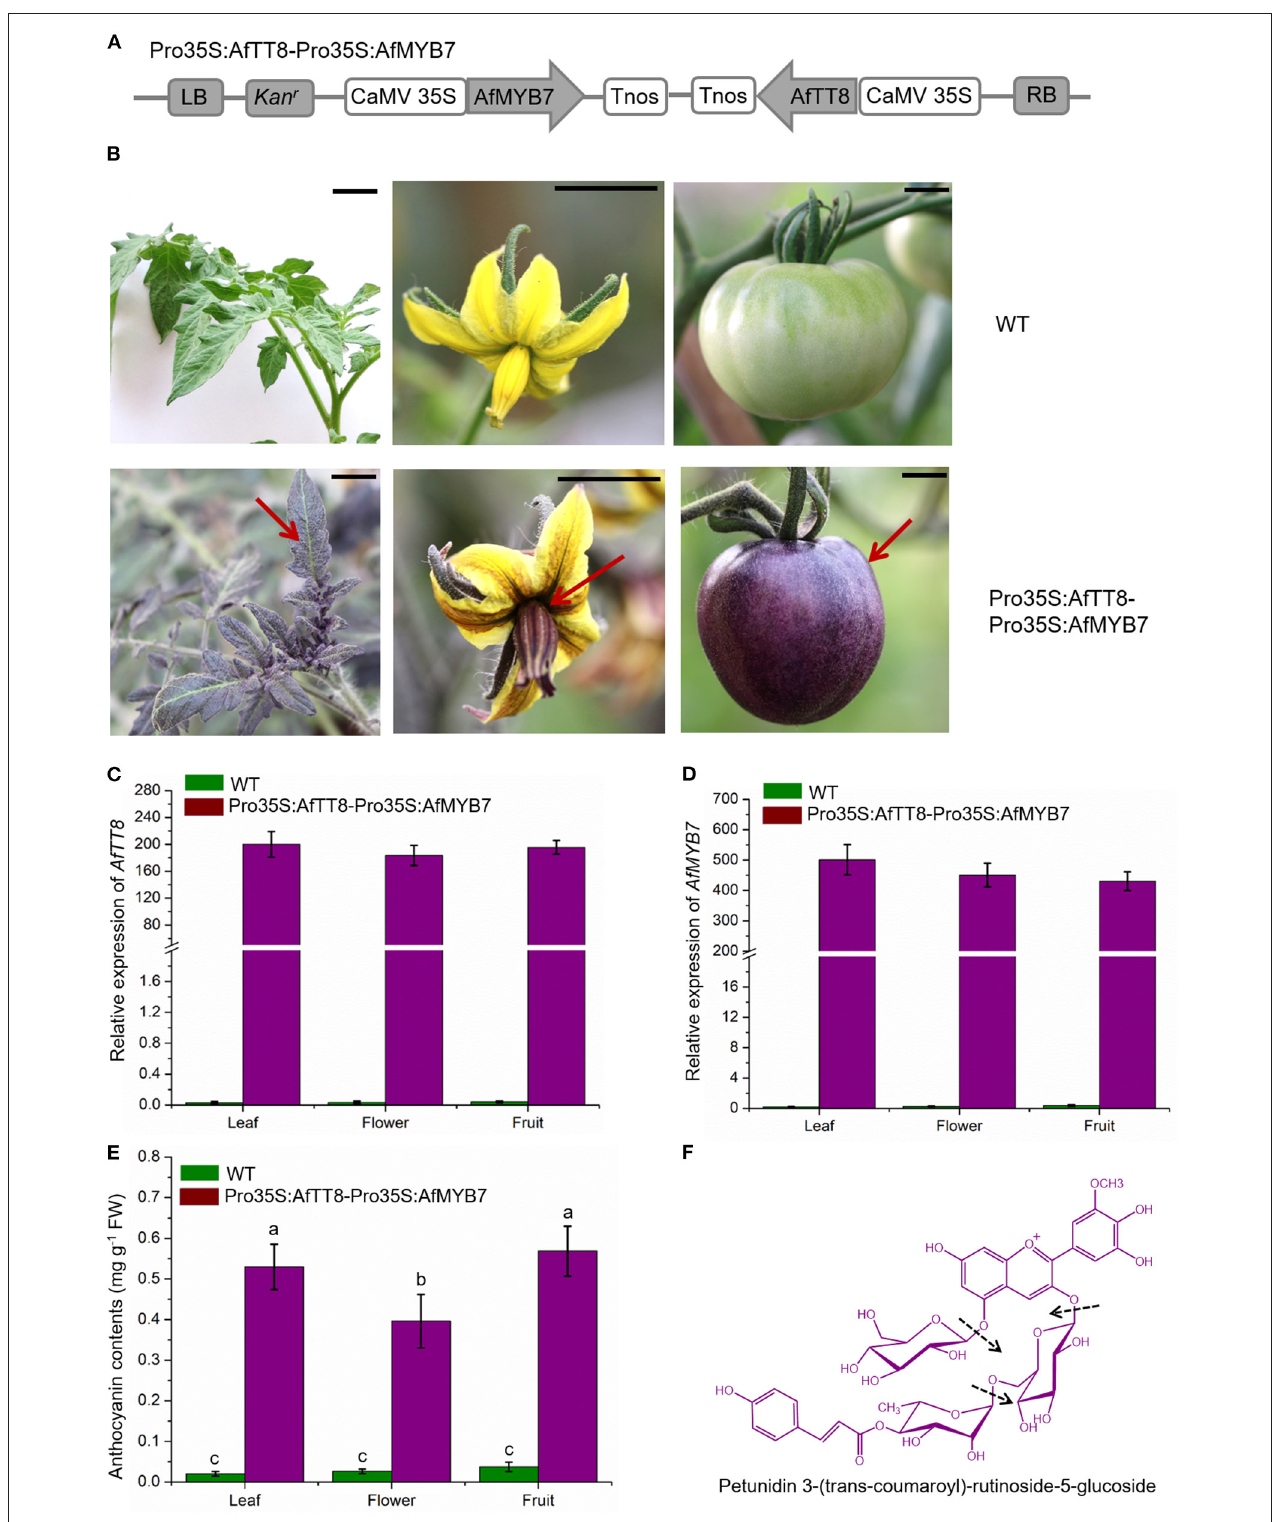
FIGURE 7 | AfMYB7 and AfTT8 coordinately trigger anthocyanin biosynthesis in various tomato tissues. (A) Schematic representation of the co-expression vector Pro35S:AfTT8-Pro35S:AfMYB7. (B) Phenotypes of WT (wild type) and transgenic tomato plants. Expression analysis of AfTT8 (C) and AfMYB7 (D) in WT and transgenic tomato lines. Gene expression levels were normalized to SlCAC . (E) The contents of total anthocyanins in various tissues. (F) Structure of the major anthocyanin petunidin 3-(trans-coumaroyl)-rutinoside-5-glucoside in reference to peak 3 in Supplementary Figure S6A and the cleavage sites were annotated by arrows. Triplicate biological replicates were conducted and different letters represent significance at p < 0.05.